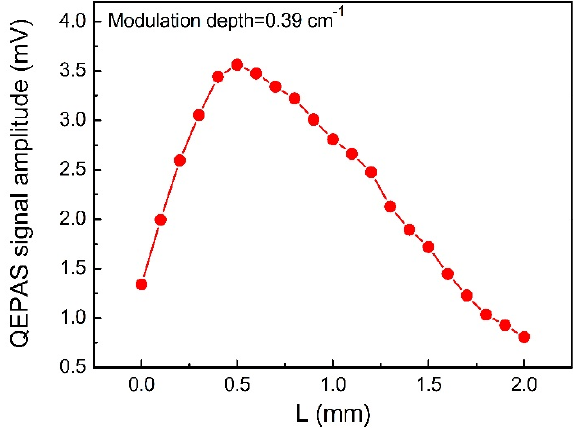
Figure 7. Experimental measured H 2 O ‐ QEPAS signal amplitude as a function of the vertical height of the laser beam.